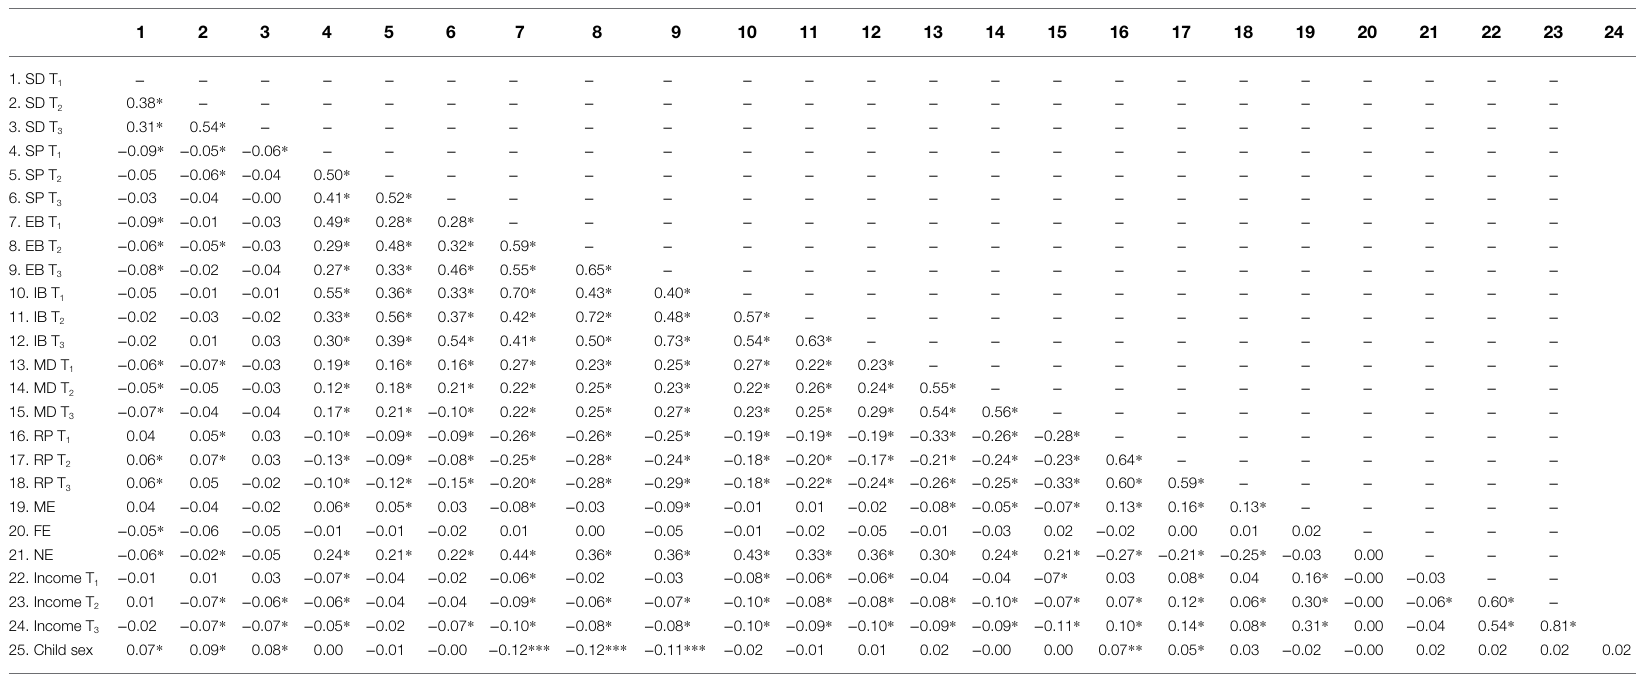
TABLE 2 | Correlations among the main and socio-demographic